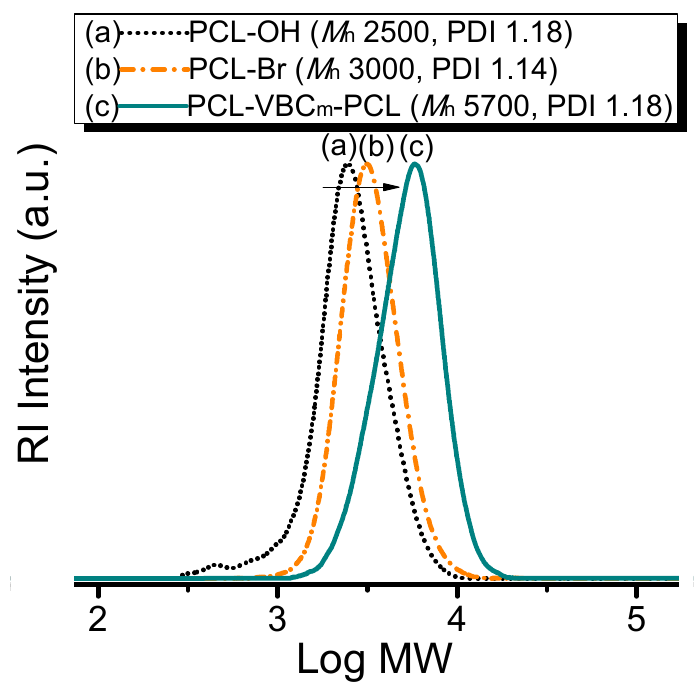
Figure 1. GPC traces (RI detector) of ( a ) PCL–OH, ( b ) PCL–Br, and ( c ) PCL-VBC m -PCL.